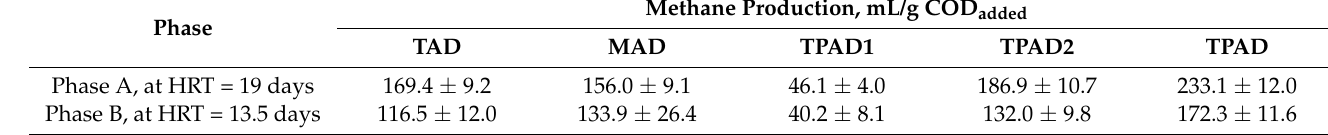
Table 4. Specific methane